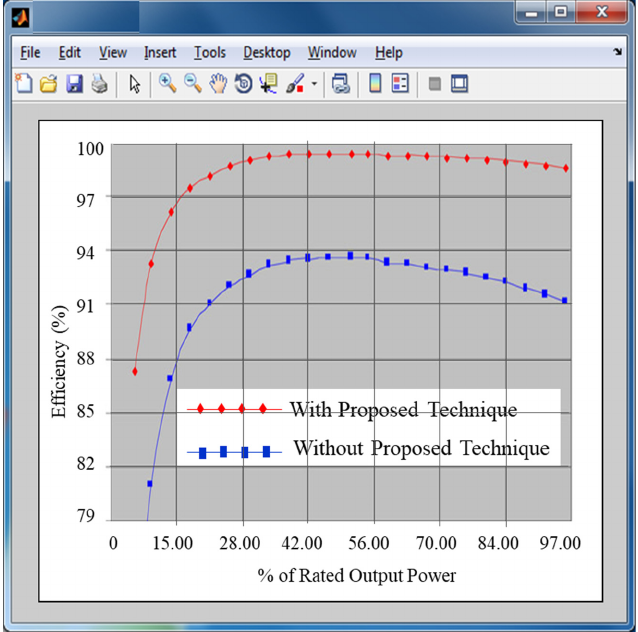
Figure 9. Inverter Efficiency with and without the Proposed